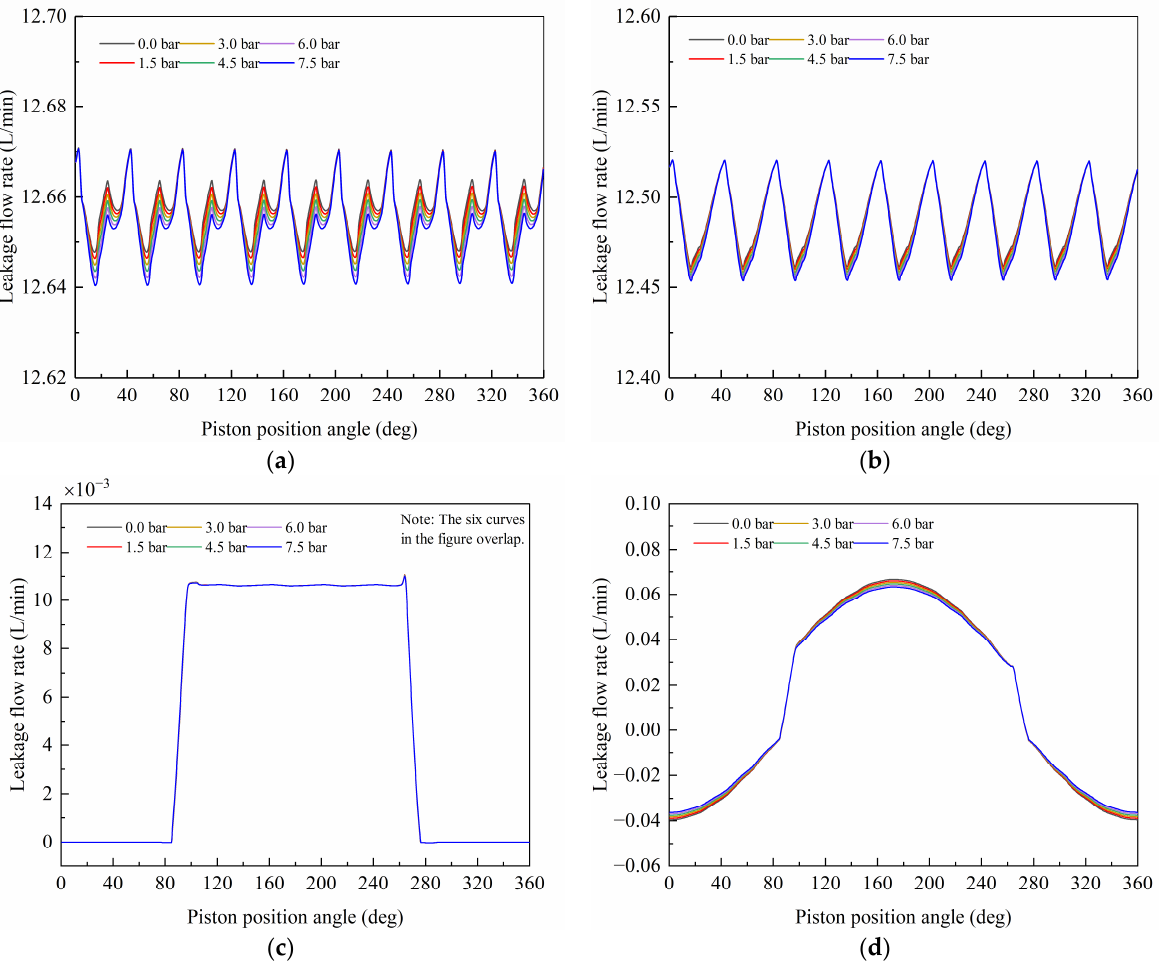
Figure 31. Leakage flow of the piston pump and kinematic pairs under different power control pilot pressures: ( a ) leakage flow rate of the piston pump; ( b ) leakage flow rate of the port plate–barrel block pair; ( c ) leakage flow rate of the slipper–swash plate pair; ( d ) leakage flow rate of the piston–barrel block pair.